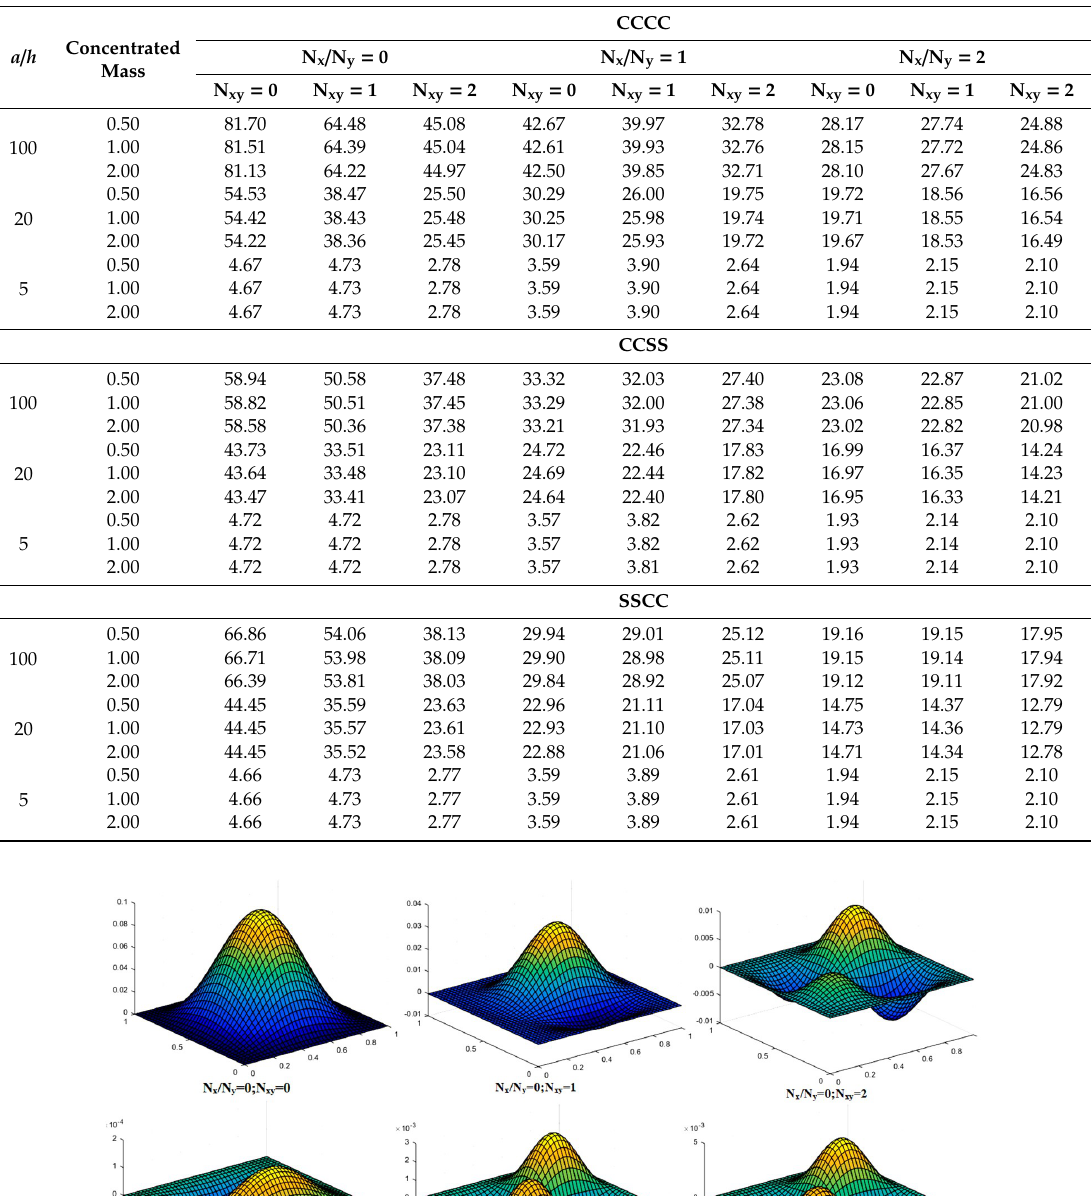
Table 8. Non-dimensional buckling load λ = ( λ b 2 /E 2 h 3 ) for a bi-axial buckling of a composite plate having lamination scheme C and additional mass.